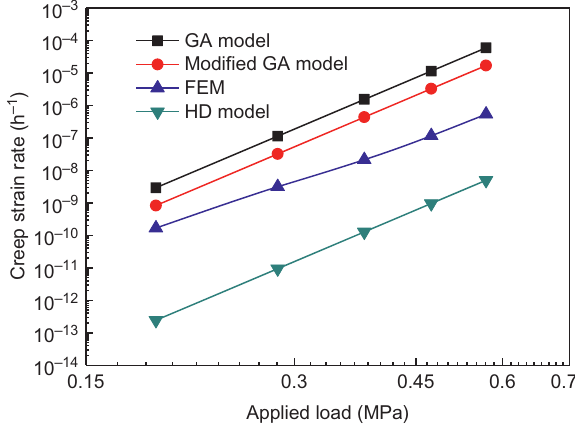
Figure 14: Load dependent creep rate by GA, HD, modified GA models and